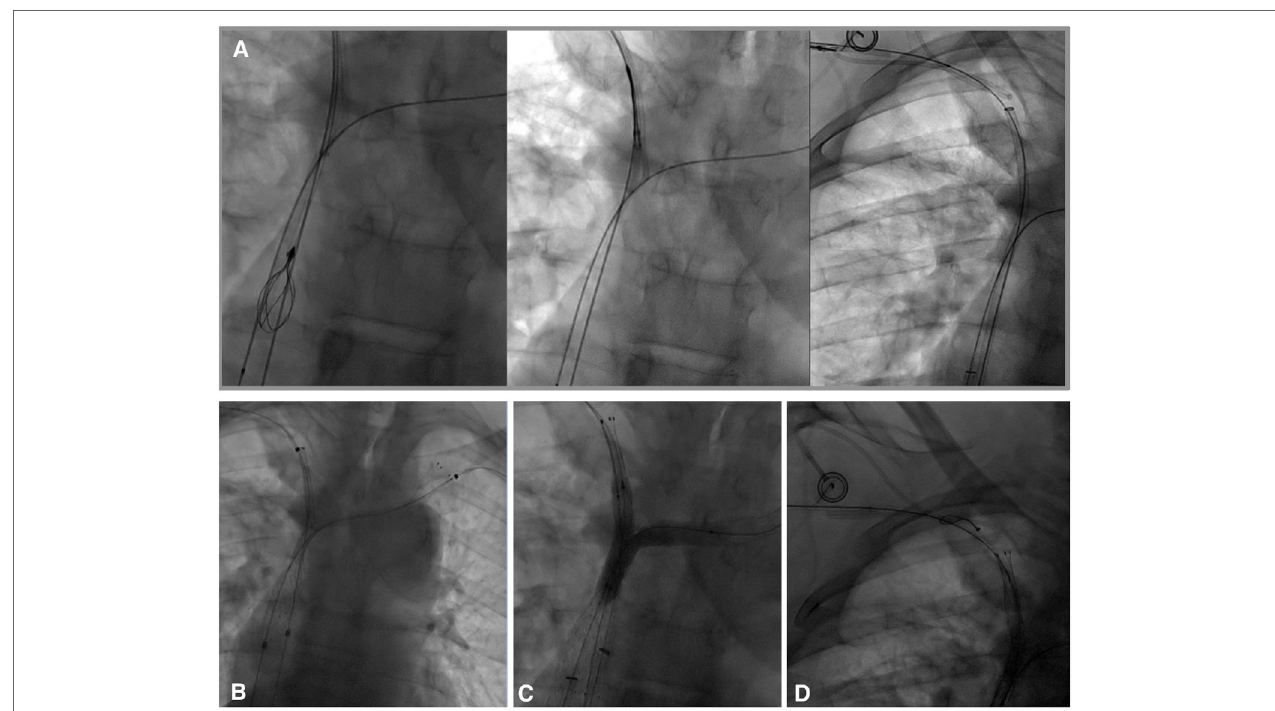
FIgURe 2 | (a) In an attempt to preserve the central venous catheter (CVC) for further chemotherapy, the CVC tip was removed before stenting from the superior vena cava into the right subclavian vein using a trifoil EN-snare from access through the basilic vein. (B) Bilateral kissing stents deployment (a 14-mm nominal diameter and 150- and 100-mm nominal lengths, Sinus-XL Flex, Optimed) and (C) balloon angioplasty (an 8-mm diameter balloon within the right stent, a 10-mm diameter balloon within the left stent) of superior vena cava (SVC) and the bilateral caudal portion of the brachiocephalic veins were performed. (D) Using a snare-loop technique, the CVC tip was removed in the SVC within the stent to facilitate subsequent chemotherapy.